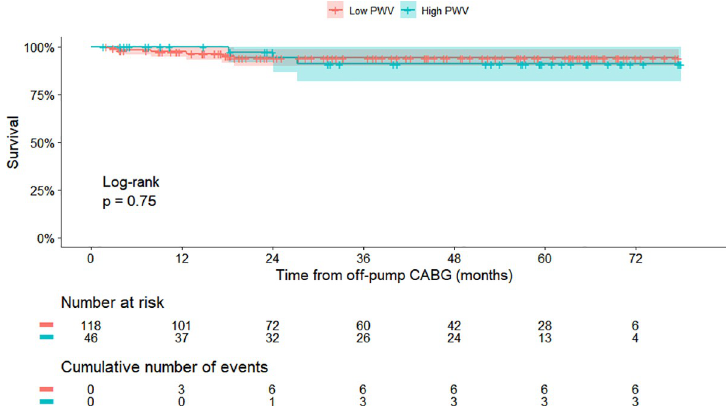
Fig 5. Survival comparison between the patients with low and high pulse wave velocities. CABG, coronary artery bypass grafting; PWV, pulse wave velocity.